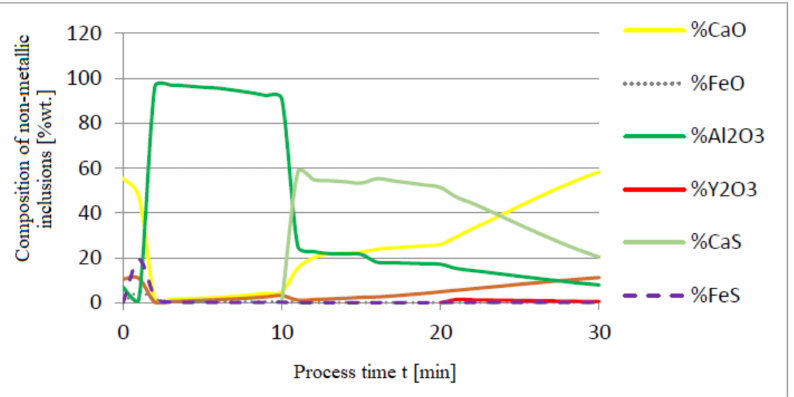
Figure 13. Change in chemical composition of non-metallic inclusions (wt.%) depending on the process time.